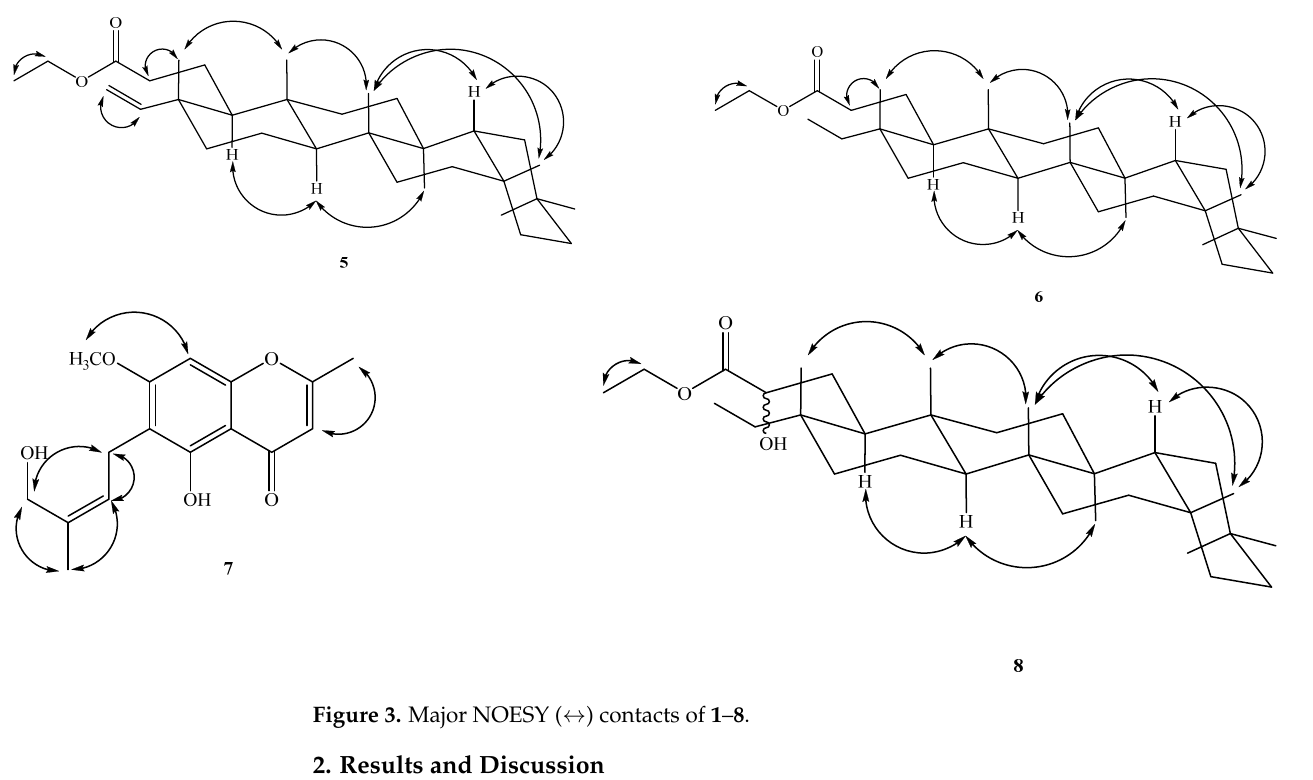
Figure 3. Major NOESY ( ↔ ) contacts of 1 ‒ 8